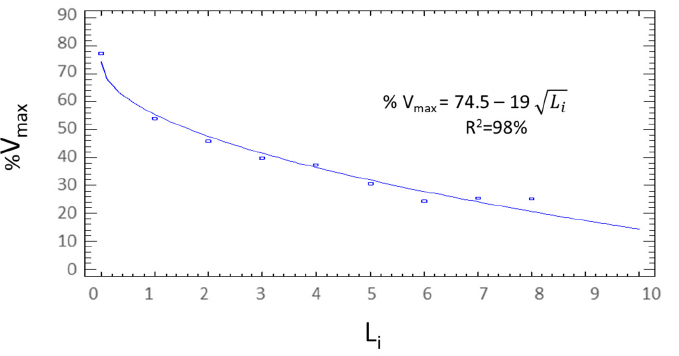
Figure 7. Behavior of the average percentage of the maximum speed as a function of the percentage interval of the path length within the intact zone (L i ), represented by a Squared Root-X model. Legend: Li = 100% of the interval = 0; Li between 91% and 100% of the interval = 1; Li between 80% and 90% of the interval = 2; Li between 70% and 80% of the interval = 3; Li between 60% and 70% of the interval = 4; Li between 50% and 60% of the interval = 5; Li between 40% and 50% of the interval = 6; Li between 30% and 40% of the interval = 7; Li between 20% and 30% of the interval = 8; Li between 10% and 20% of the interval = 9; and Li < 10% of the interval = 10. A statistically significant ( p value = 0.0083) correlation model (Squared-X), with a 95% safety level, was obtained between the % Vmax and the percentage of deteriorated zones (L d ) within the theoretical route, with a correlation coefficient R = 0.83 and coefficient of determination R 2 = 69% (Figure 8).